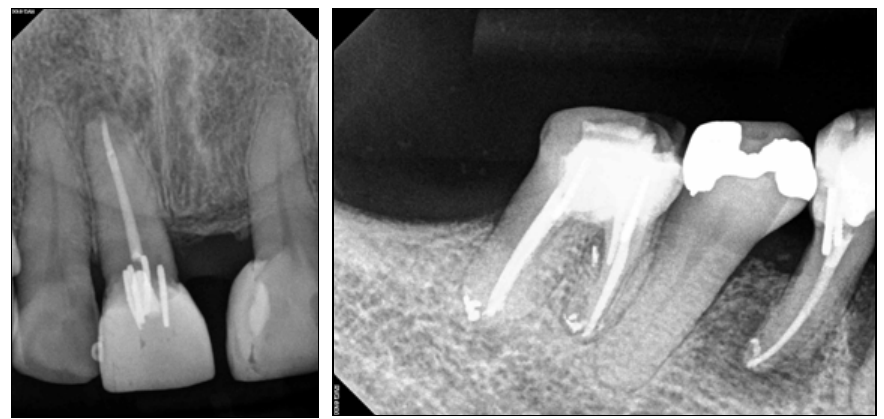
Figure 3. Periapical radiographs taken following successful endodontic treatment of the 11 and 44.